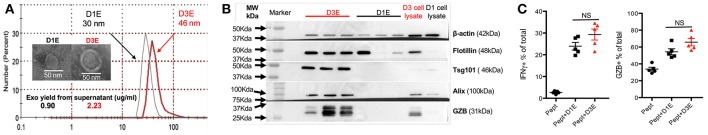
CTLs secrete functional exosomes soon after 3SI stimulation. Exosomes were purified from 24-h (D1E) or 72-h (D3E) supernatant of CTLs stimulated with 3SI (MHC I/N4+B7-1+IL-12). (A) Representative size distribution and electron microscopy of 3 experiments. (B) Western blot based on 10 μg protein of exosomes from 3 different experiments. (C) Naive OT-I cells were stimulated with low-affinity peptide T4 with or without D1E or D3E for 2 days before staining.